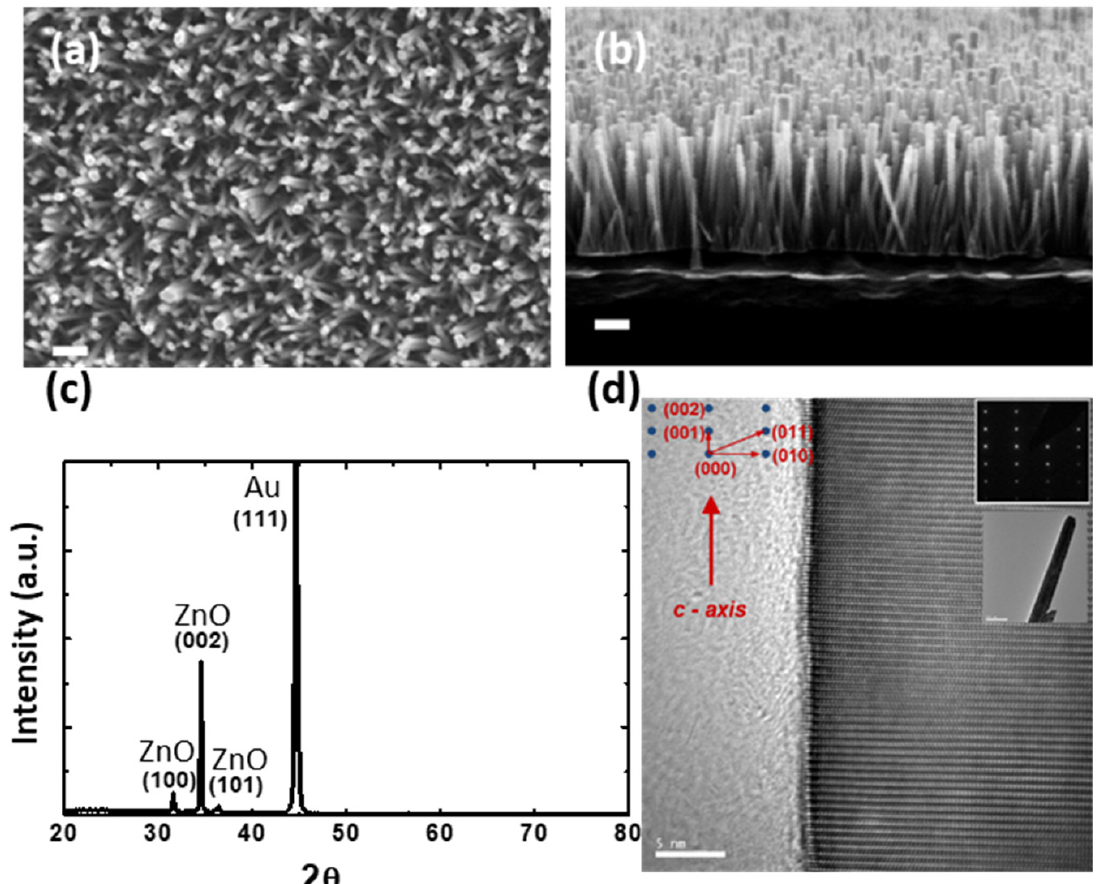
Figure 1. Representative SEM images show: ( a ) top view; ( b ) side view of as-grown vertically orientated ZnO NW arrays on the gilded Si substrates (scale bar: 200 nm); ( c ) XRD analysis of hydro- thermally-grown ZnO NWs on gilded Si substrates; and ( d ) HRTEM image of a representative ZnO NW.